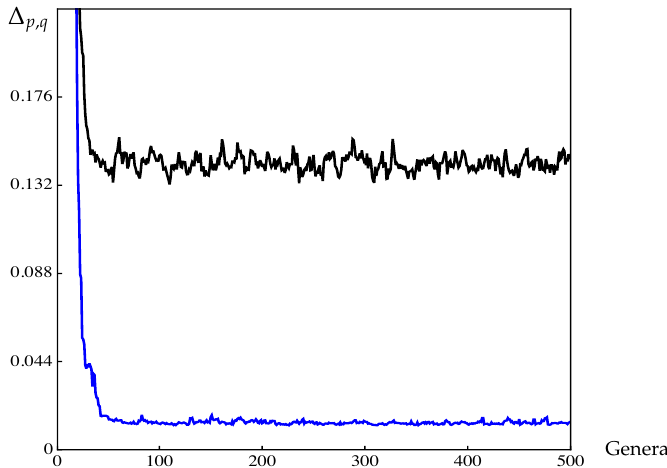
Figure 23. The black curve is the ∆ p , q value for the discrete approximation, and the blue one is the respective curve for the continuous approximation of NSGA-II for MOP (Equation (17)).